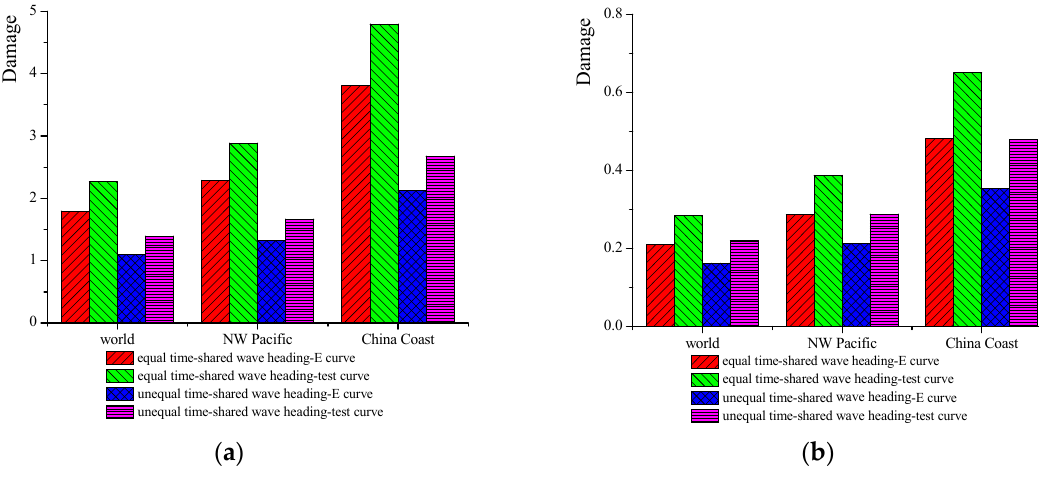
Figure 11. Compared results of fatigue damage as follows: ( a ) Hot spot 1 of model 2 and ( b ) hot spot 4 of model